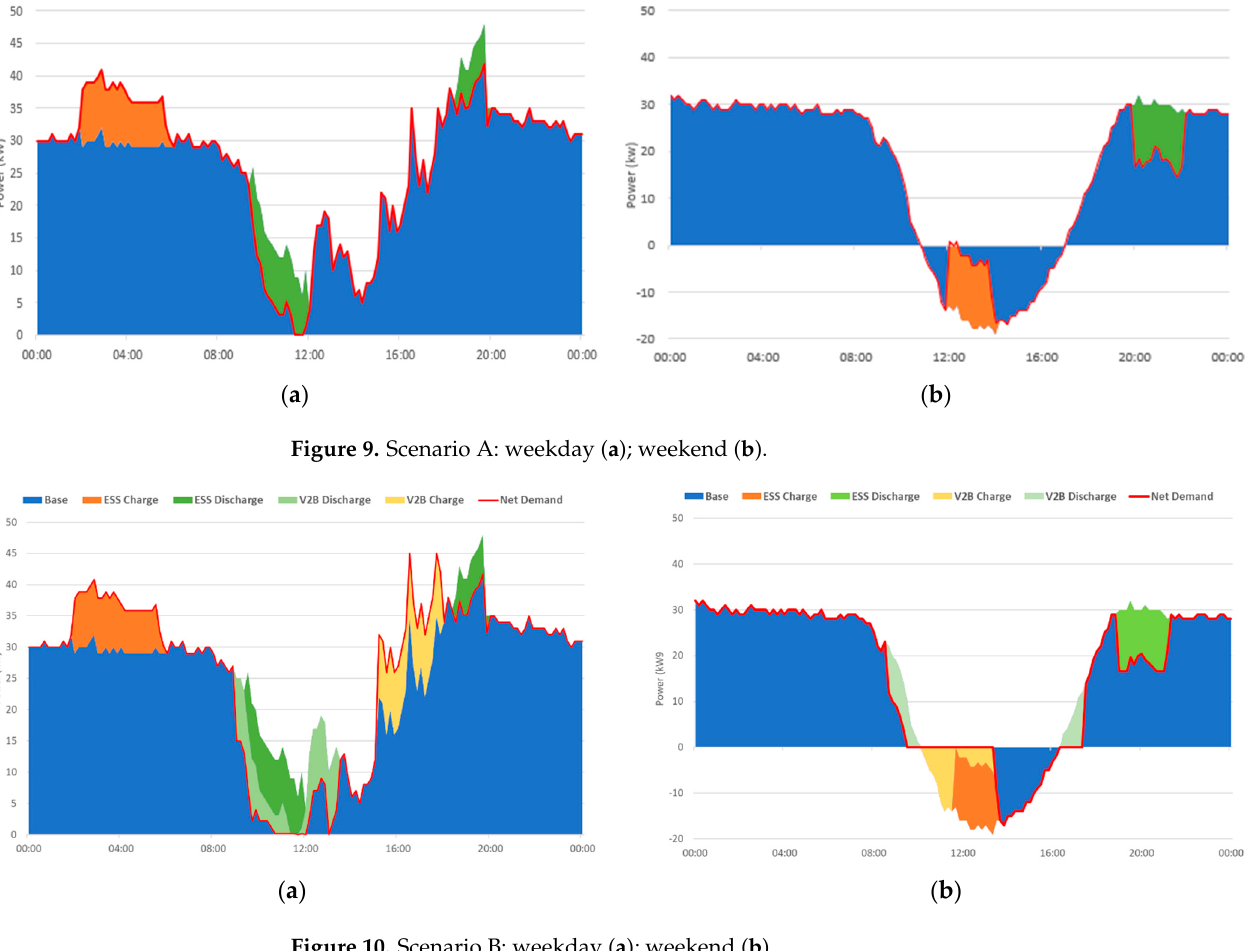
( b ) Figure 11. Scenario C: weekday ( a ); weekend ( b ). ( a ) ( b ) Figure 12. Scenario D: weekday ( a ); weekend ( b ). 4. Discussion 4.1. Microgrid Efficiency Analysis Following the experimental results, the obtained data were gathered and Table 7 was created to summarize the efficiencies of all the tested assets as well as to evaluate the final